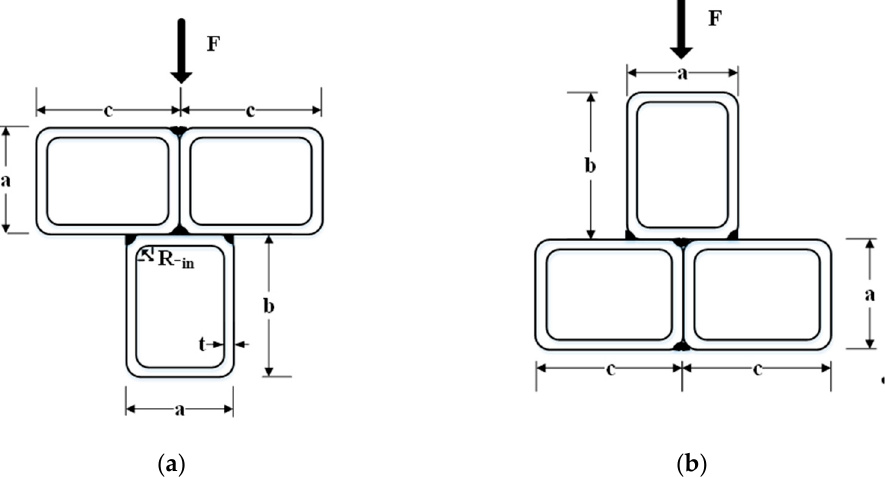
Figure 5. Cross-sections under different bending moments: ( a ) Positive bending moment; ( b ) negative bending moment. MT-HST1-P